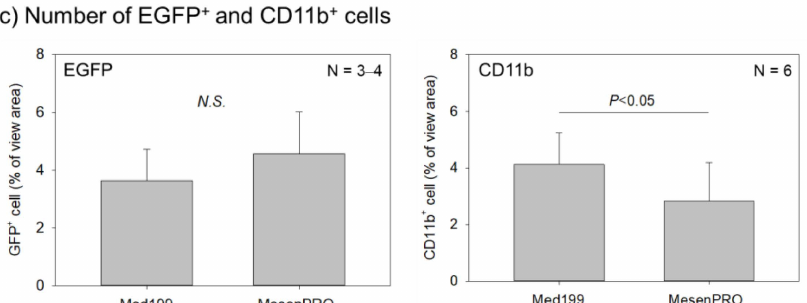
Figure 5. Effects of culture media on the infiltration of enhanced green fluorescent protein + (EGFP + ) and CD11b + cells. ( a ) EGFP immunostaining (inset: higher magnification of the selected region), ( b ) CD11b immunostaining. Individual positive cells were stained dark brown. ( c ) Quantification of the immunohistochemical data. N.S. : not